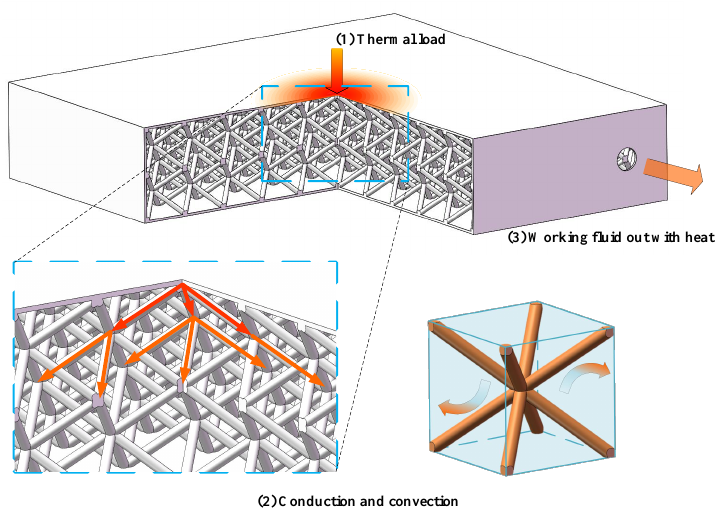
Figure 3. Working process of heat exchanger with lattice structure. (The direction of the arrow indicates the direction of heat